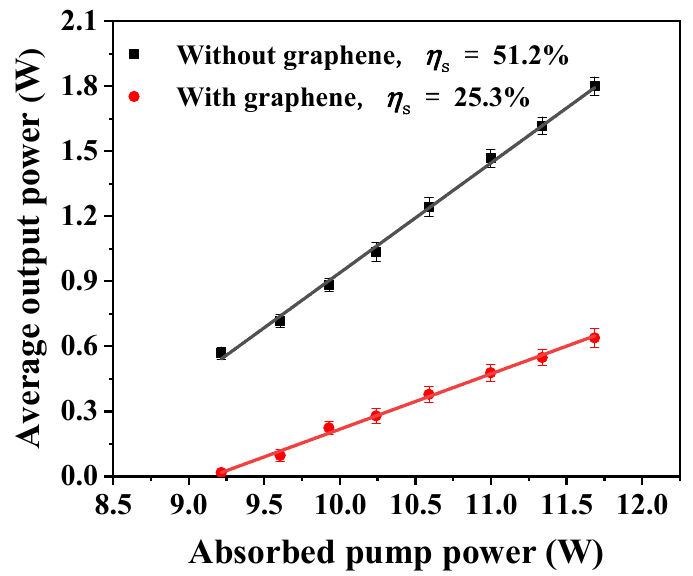
Figure 2. Average output power vs. the absorbed pump power with and without the graphene.